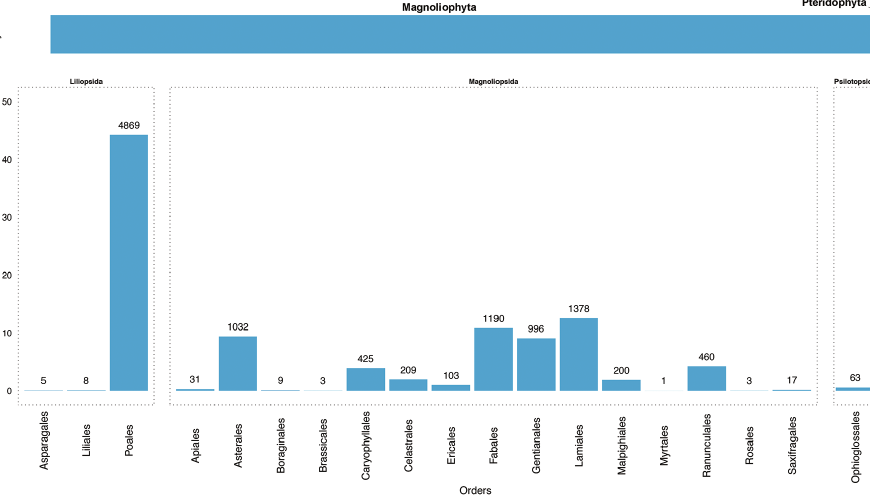
Figure 2. Taxonomic coverage. The upper bar shows the percentage of records of the dataset belonging to each phylum. The bottom bars show the percentage of total records in the dataset by order. The number of records is included above the bars. The order bars is aggregated by class.